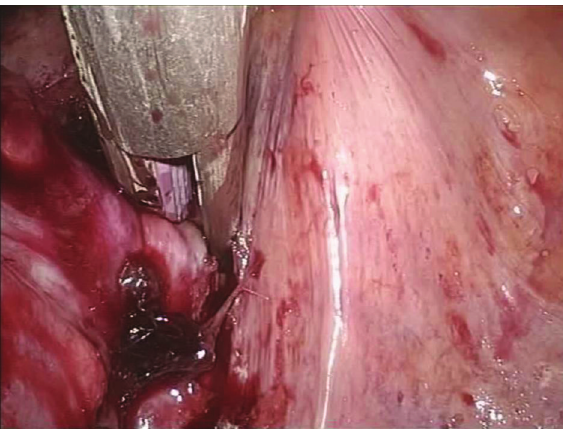
Figure 4: Position of placed Endo articulating linear stapler.